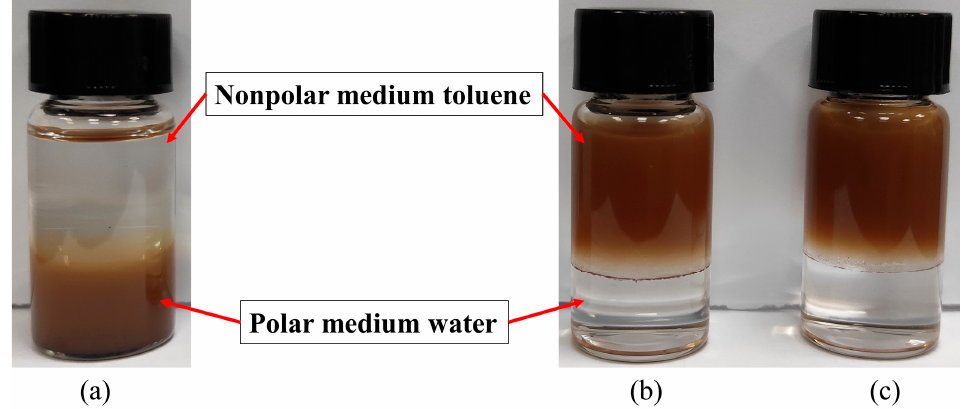
Figure 2. Macro picture for dispersion of ( a ) Fe 3 O 4 @SiO 2 -PrSO 3 H, ( b ) Fe 3 O 4 @SiO 2 -Me&PrSO 3 H and ( c ) Fe 3 O 4 @SiO 2 -Oc&PrSO 3 H in water and toluene two-phase system.